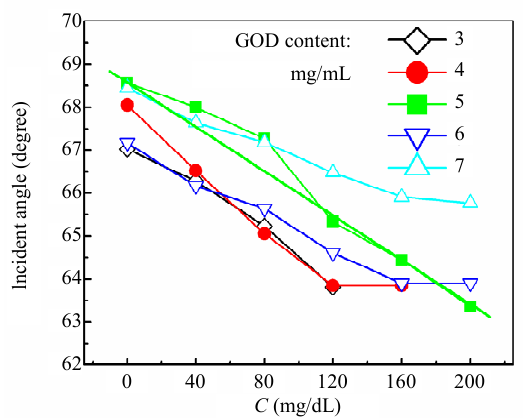
Fig. 5 Effect of the GOD content on the sensitivity, where the content of GOD increases from 3 mg/mL to 7